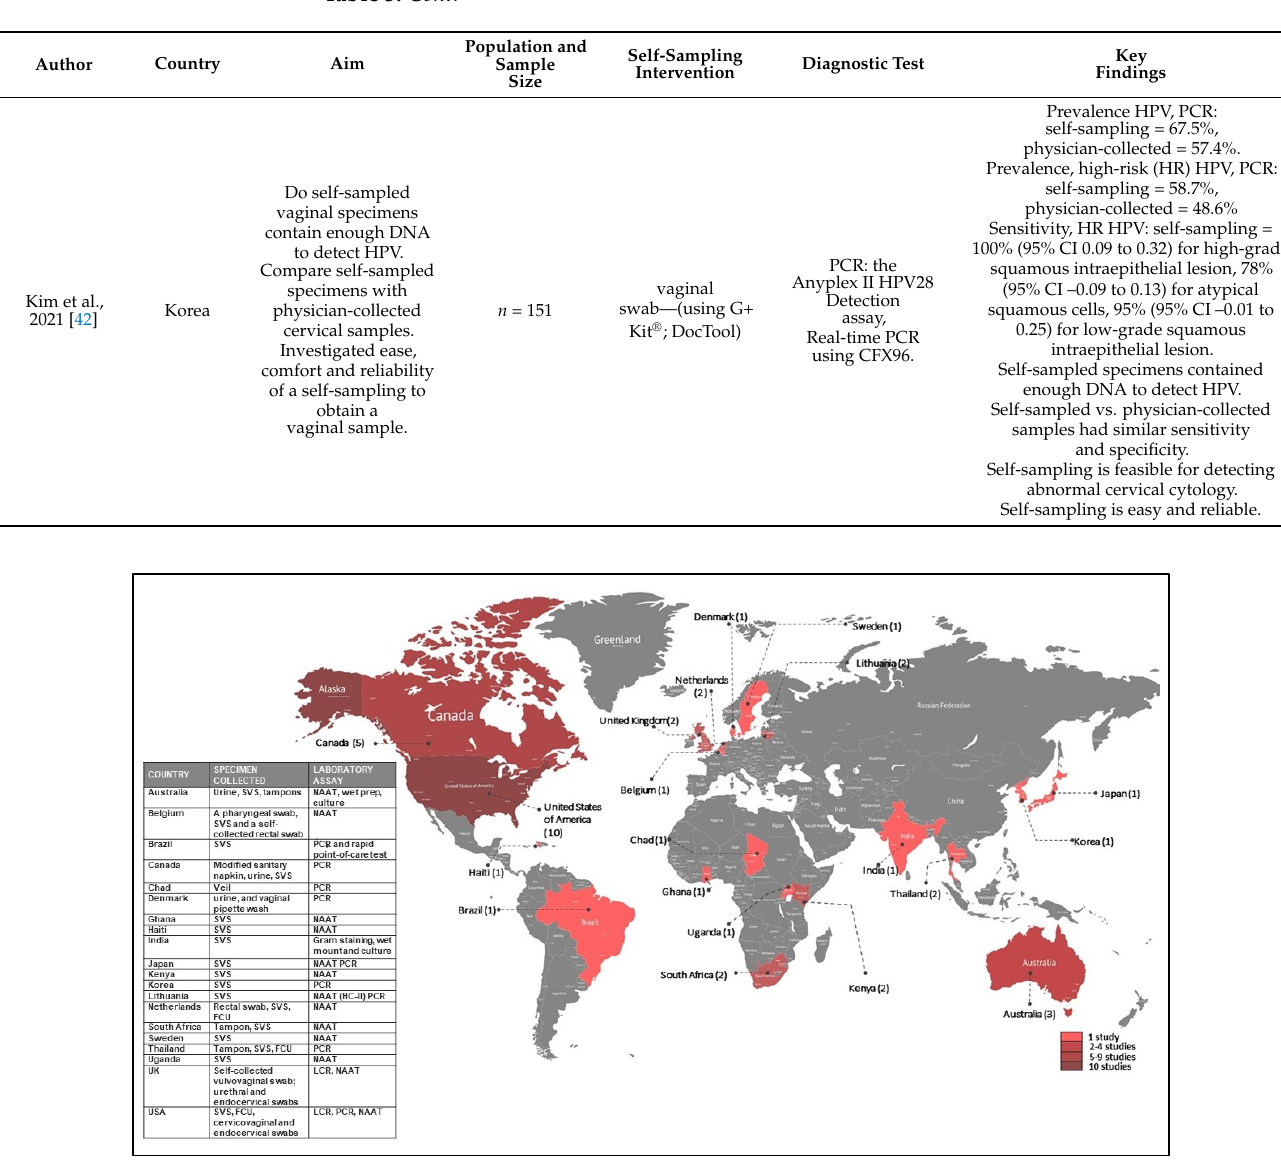
Figure 2. World map showing global evidence on self-sampling interventions for diagnosing STIs in women.